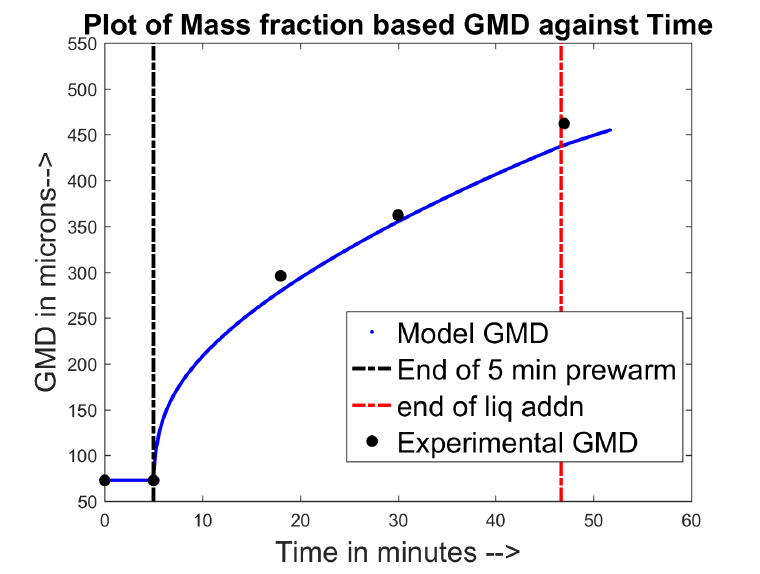
Figure 5. Experimental vs. model geometric mean diameters (GMDs) for validation Set